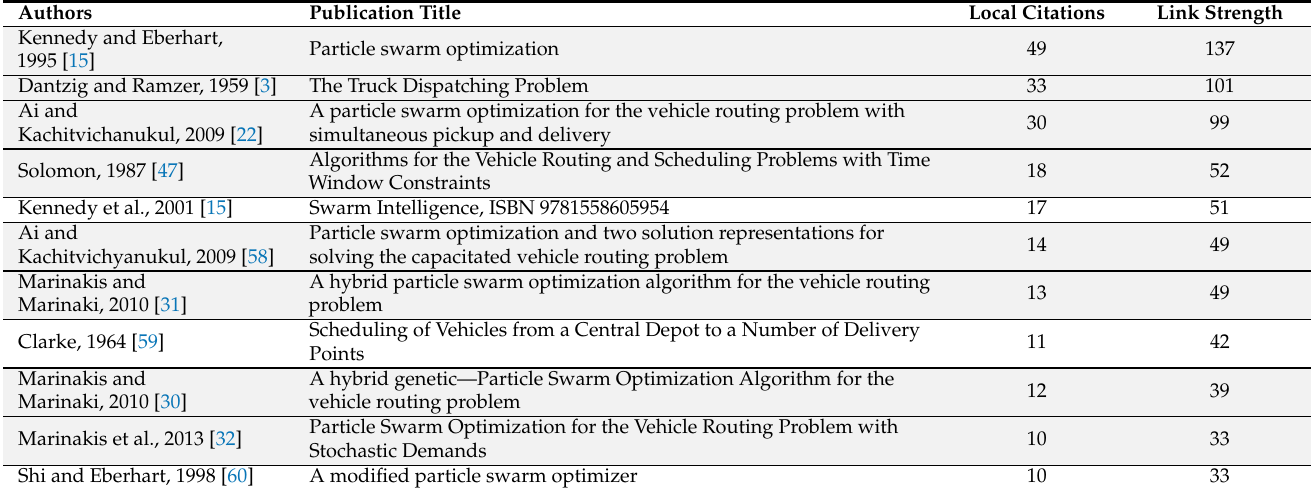
Table 9. Key co-cited PSO/VRP documents from the Web of Science query, n =